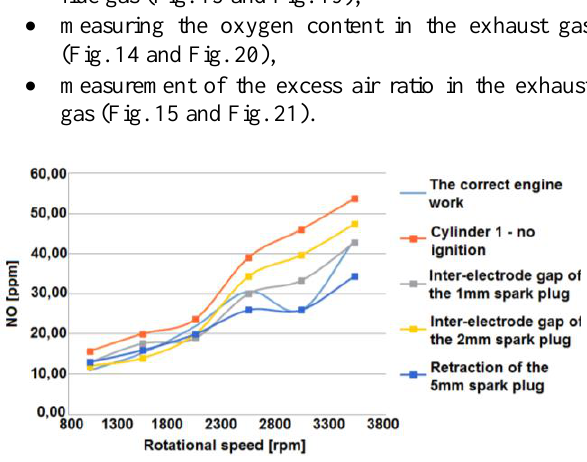
Fig. 10. The content of nitrogen oxides in the exhaust gas of the BMW M10B18 engine